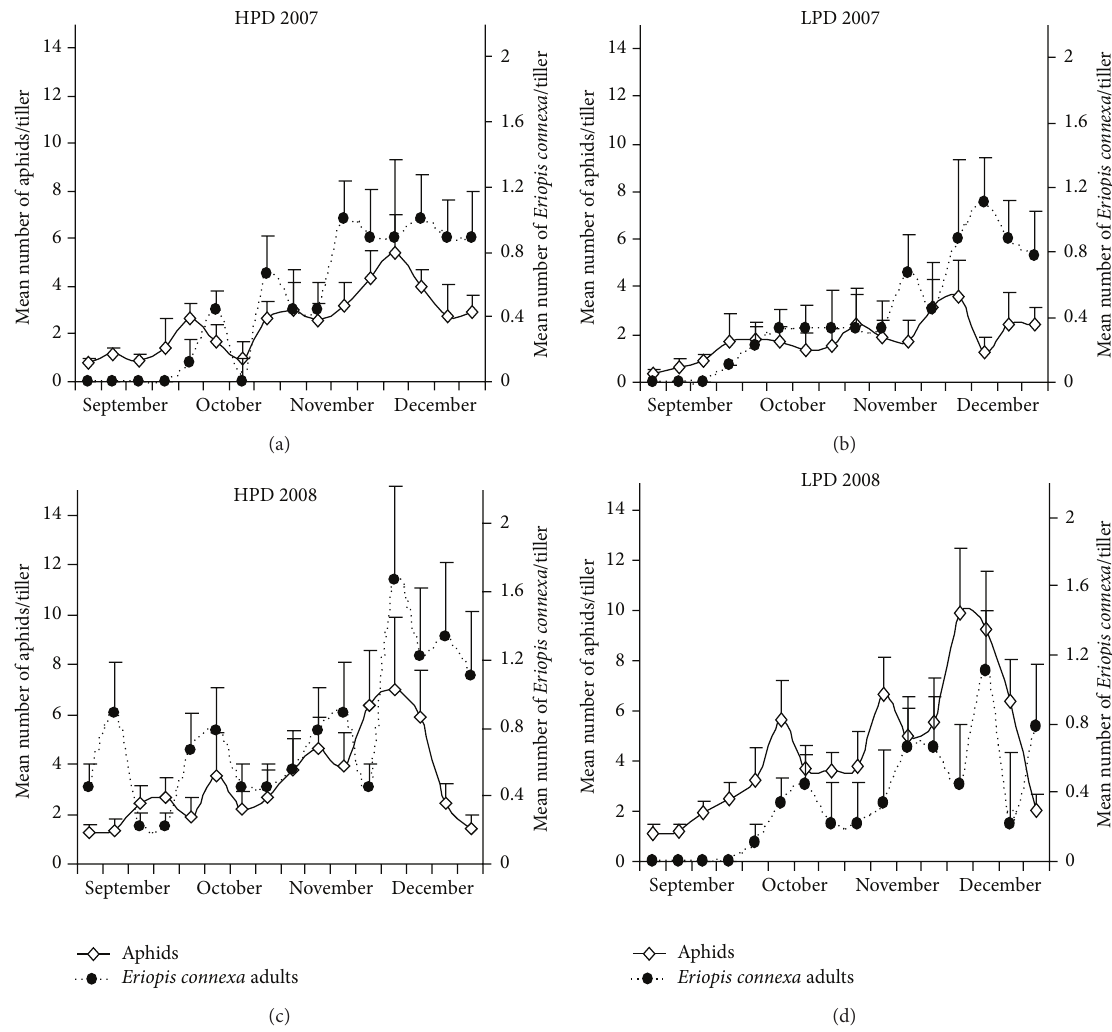
Figure 3: Seasonal abundance of aphid and adults of Eriopis connexa in wheat crops with a high (HPD) and low plant diversity (LPD). Balcarce, 2007 and 2008. Mean number of aphids per tiller ± SE and mean number of Eriopis connexa per tiller ± SE.